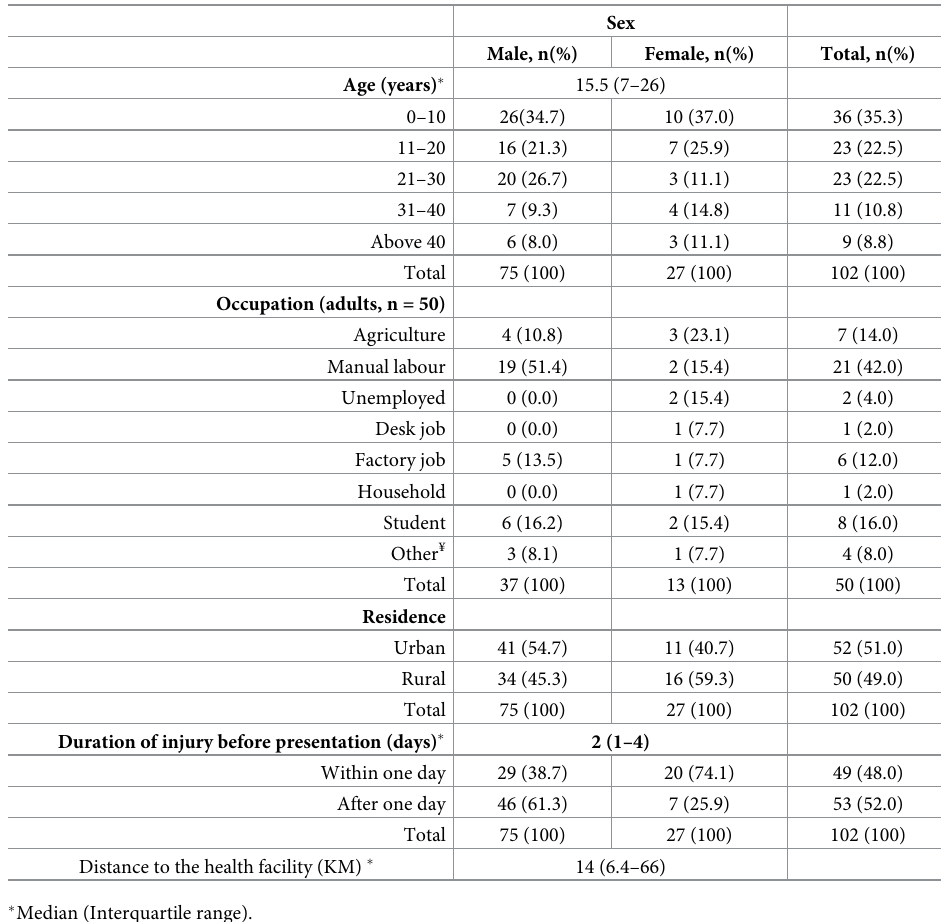
Table 1. Sociodemographic characteristics.